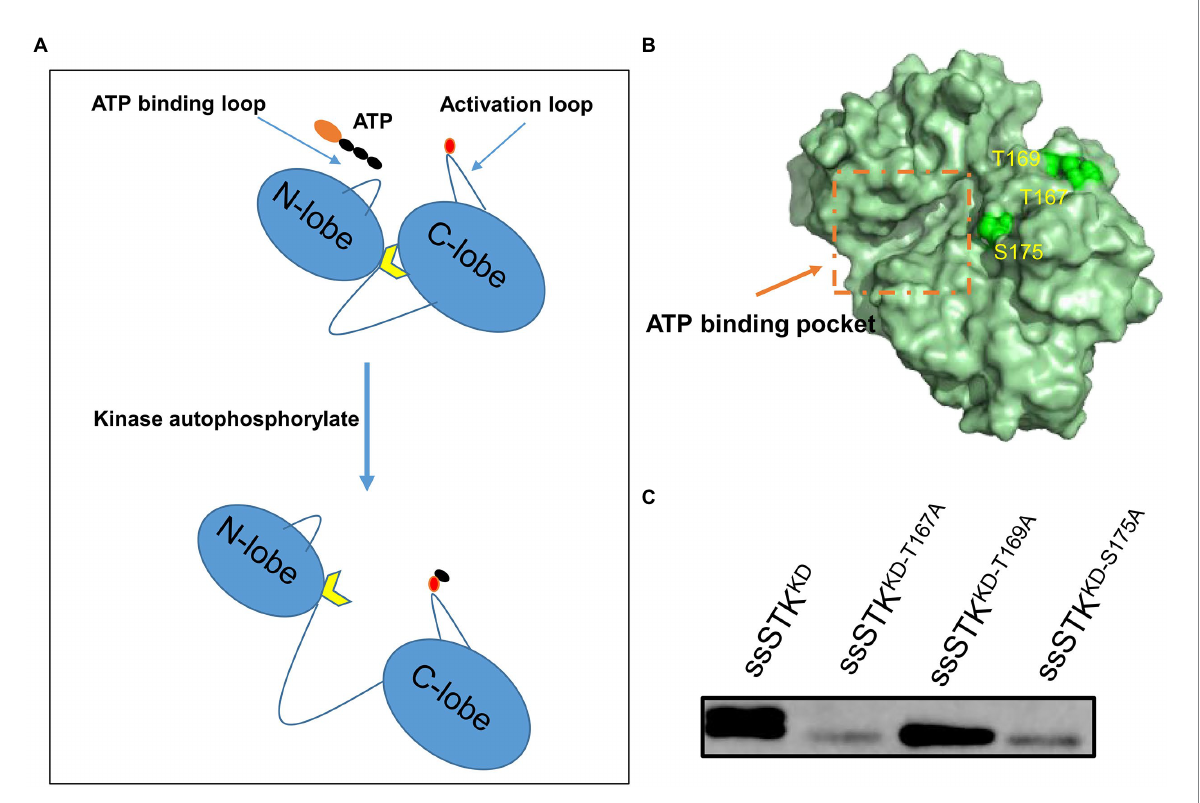
FIGURE 1 Identification of autophosphorylation sites of ssSTK. (A) Schematic diagram of the process of autophosphorylation of STK. The autophosphorylation sites of the kinase activation loop are phosphorylated, which exposes the substrate binding sites. Black ellipsoid denotes phosphate group; Red ellipsoid denotes the autophosphorylation sites of kinase activation loop; Yellow arrow denotes the substrate binding sites. (B) The simulated 3D structure of ssSTK. The amino acid sequence of ssSTK was analyzed using the I-TASSER server. The image was generated by PyMOL software. Green spheres represent the predicted autophosphorylation sites of ssSTK. (C) The autophosphorylation assay. Each purified protein (ssSTK KD , ssSTK KD-T167A , ssSTK KD-T169A , and ssSTK KD-S175A ) was added to kinase buffer including 50 μ M ATP, respectively. Then, the mixtures were incubated at 37 ° C for 30 min and terminated by the addition of SDS loading buffer. The autophosphorylation levels of these samples were measured by western blotting using an anti-P-Threonine mouse monoclonal antibody; The experiment was carried out two times independently under the same